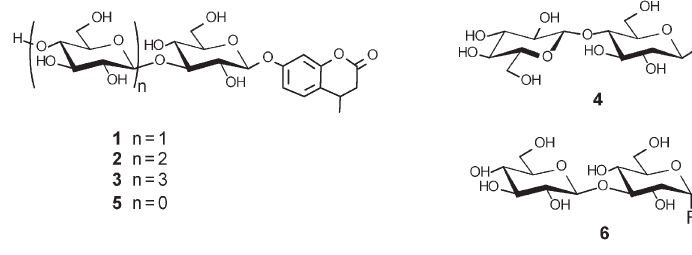
Figure 2. Substrates for wild type and E170A LamA used in this study: 1 = 4-methylumbelliferyl β -laminaribioside (Glc β 3Glc β 3-MU); 2 = 3- O - β -cellobiosyl- β - D -glucopyranoside (Glc β 4Glc β 3Glc β